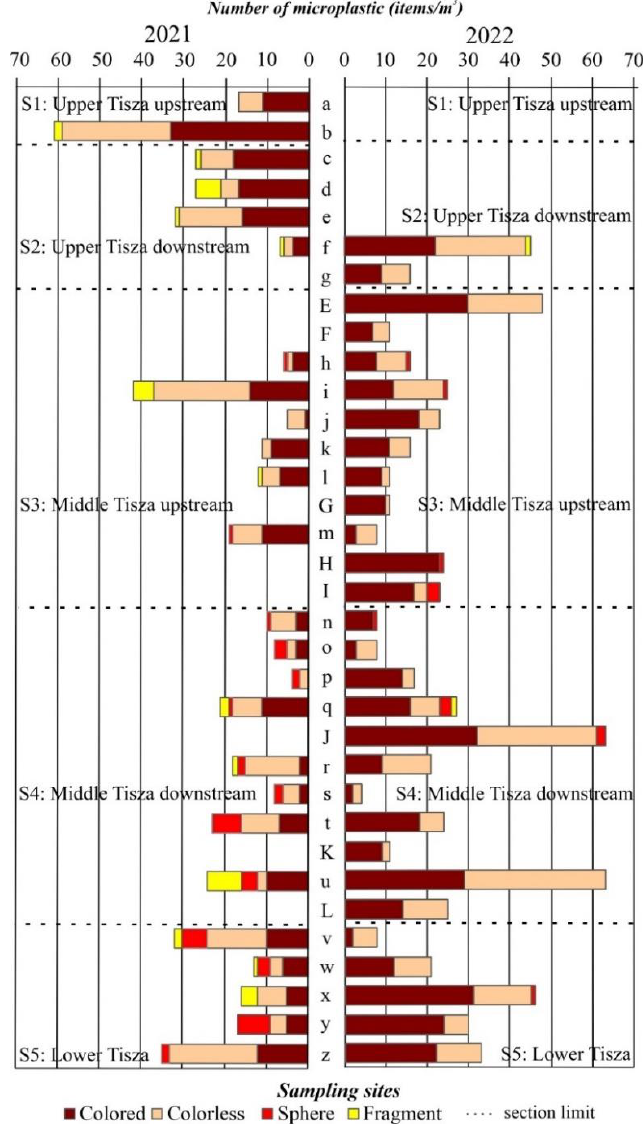
Figure 4. Amount transported fibres, microplastic spheres and fragments in 2021 and 2022. Table 1. Mean microplastic content (items/m 3 ) of the Tisza and its tributaries in 2021 and 2022. Upper Tisza Middle Tisza Lower Tisza